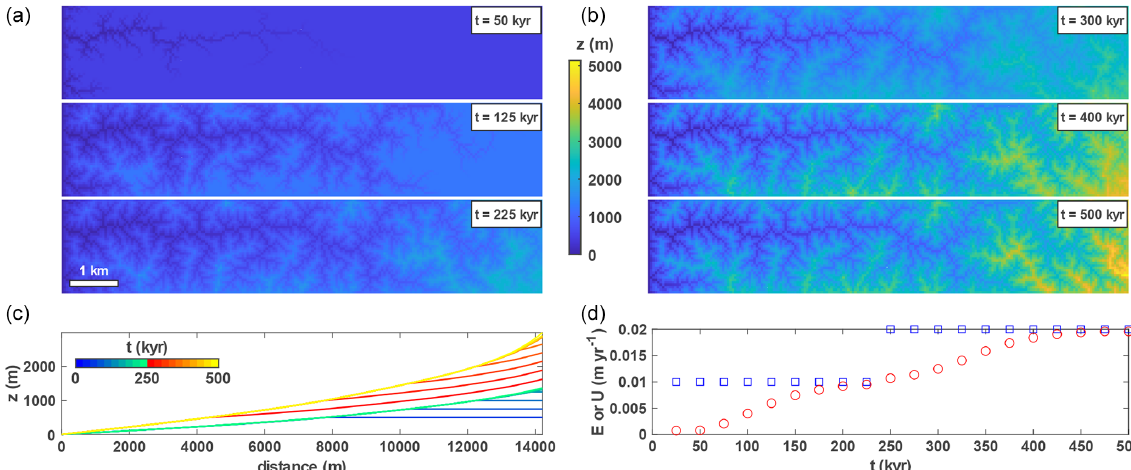
Figure 5. Dynamic evolution of the topography and knickpoint migration over 500kyr. The initial uplift rate U = 10mmyr − 1 is doubled after 250kyr. (a) Topography before the increase in uplift at 50 (top panel), 125 (middle panel) and 225kyr (bottom panel). (b) Topography after the increase in uplift at 300 (top panel), 400 (middle panel) and 500kyr (bottom panel). (c) Temporal evolution of the longest river profile shown at every time step (except the first one), with the “winter” and “autumn” colour map showing river profiles before and after the increase in uplift. (d) Temporal evolution of the uplift (blue squares) and erosion (red circles)